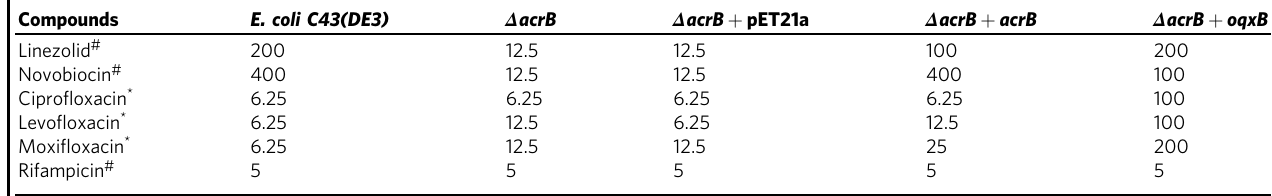
Table 2 MIC values with acrB and oqxB complementation in E. coli C43(DE3) Δ acrB . Compounds